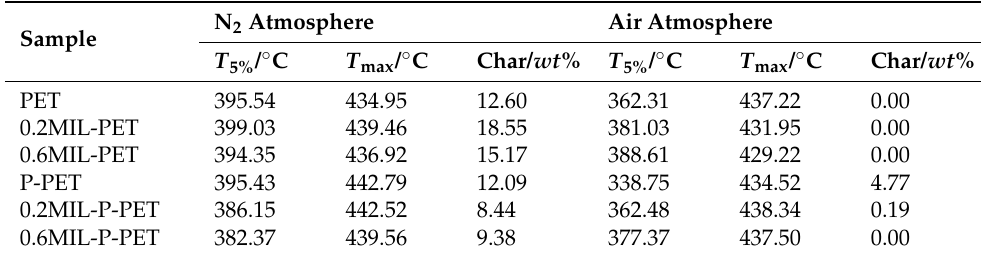
Figure 3. ( a ) TG (thermogravimetric analysis) in N 2 atmosphere ( b ) DTG (differential thermal gravity) in N 2 atmosphere ( c ) TG in air atmosphere ( d ) DTG in air atmosphere of PET, 0.2MIL-PET, 0.6MIL-PET, P-PET, 0.2MIL-P-PET, 0.6MIL-P-PET. Table 2. TG and DTG data of MIL-PET and MIL-P-PET